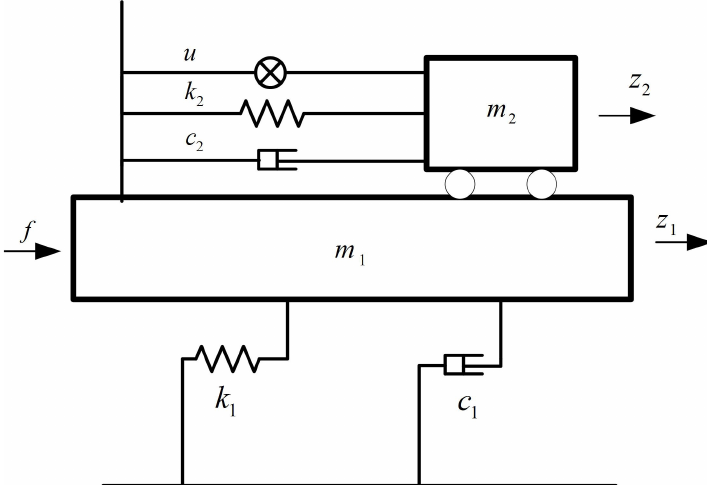
Figure 1. The sketch of an offshore structure with AMD mechanisms [14], with persmission from Elsevier,